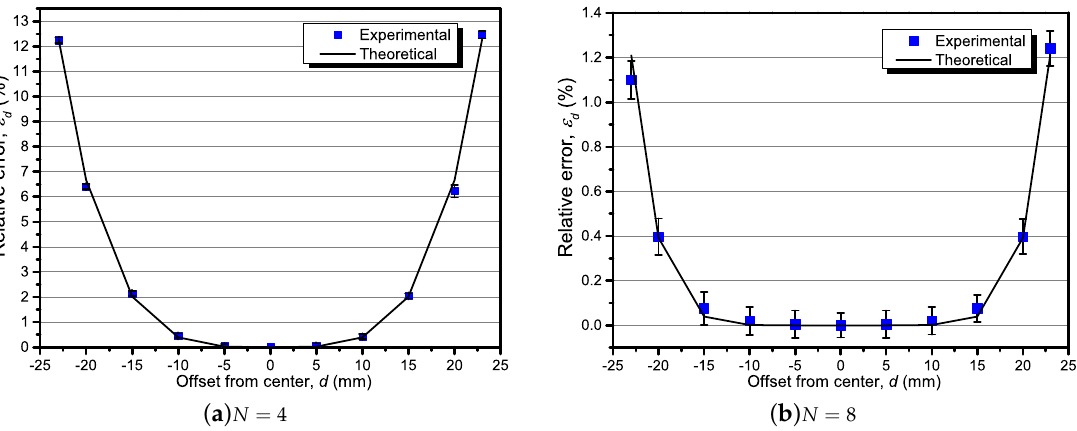
Figure 7. The un-center effect with various offset distances d from − 23 mm to 23 mm, with β = 0 ◦ , α 0 = 0 ◦ , and test current f = 400 Hz @ 50